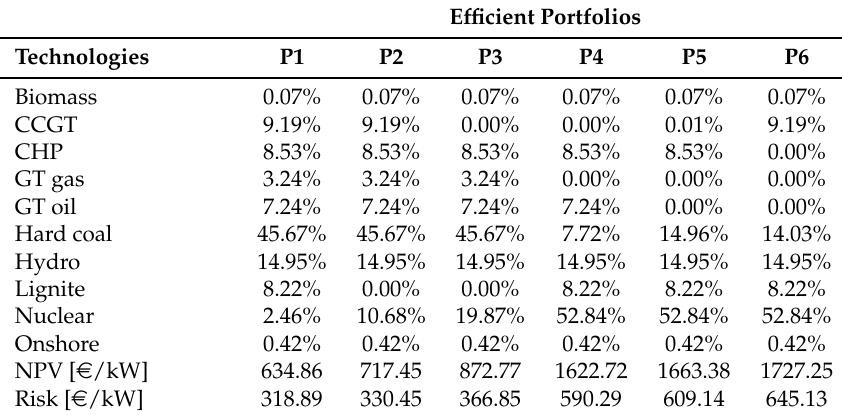
Table A7. Efficient portfolios according to the MV Model for existing technologies.